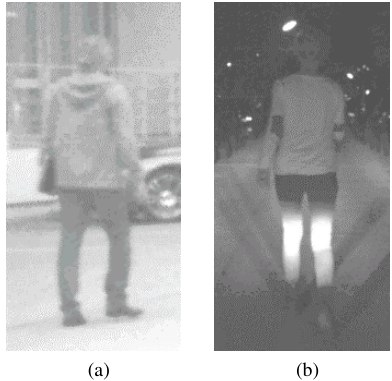
Figure 2: Images of a vehicle camera system with original reso- lution, but increased brightness. Different appearance of pedes- trians: a) during a cloudy day, b) in the